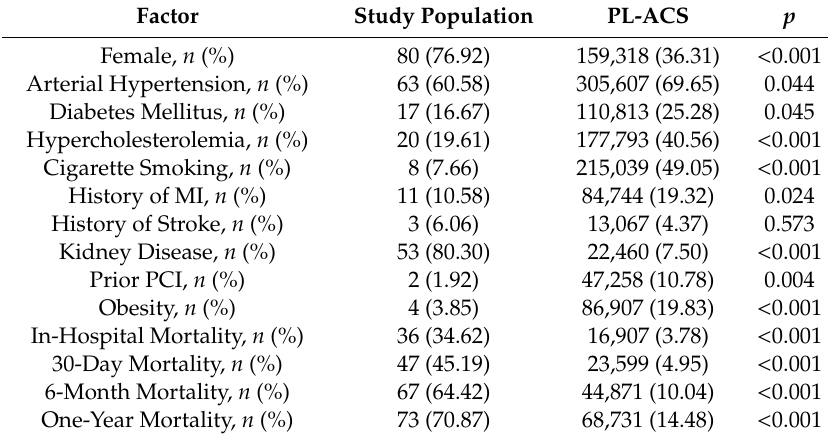
Table 6. Comparison of the study population ( ≥ 100 years old) and the whole Polish Registry of Acute Coronary Syndromes (PL-ACS)